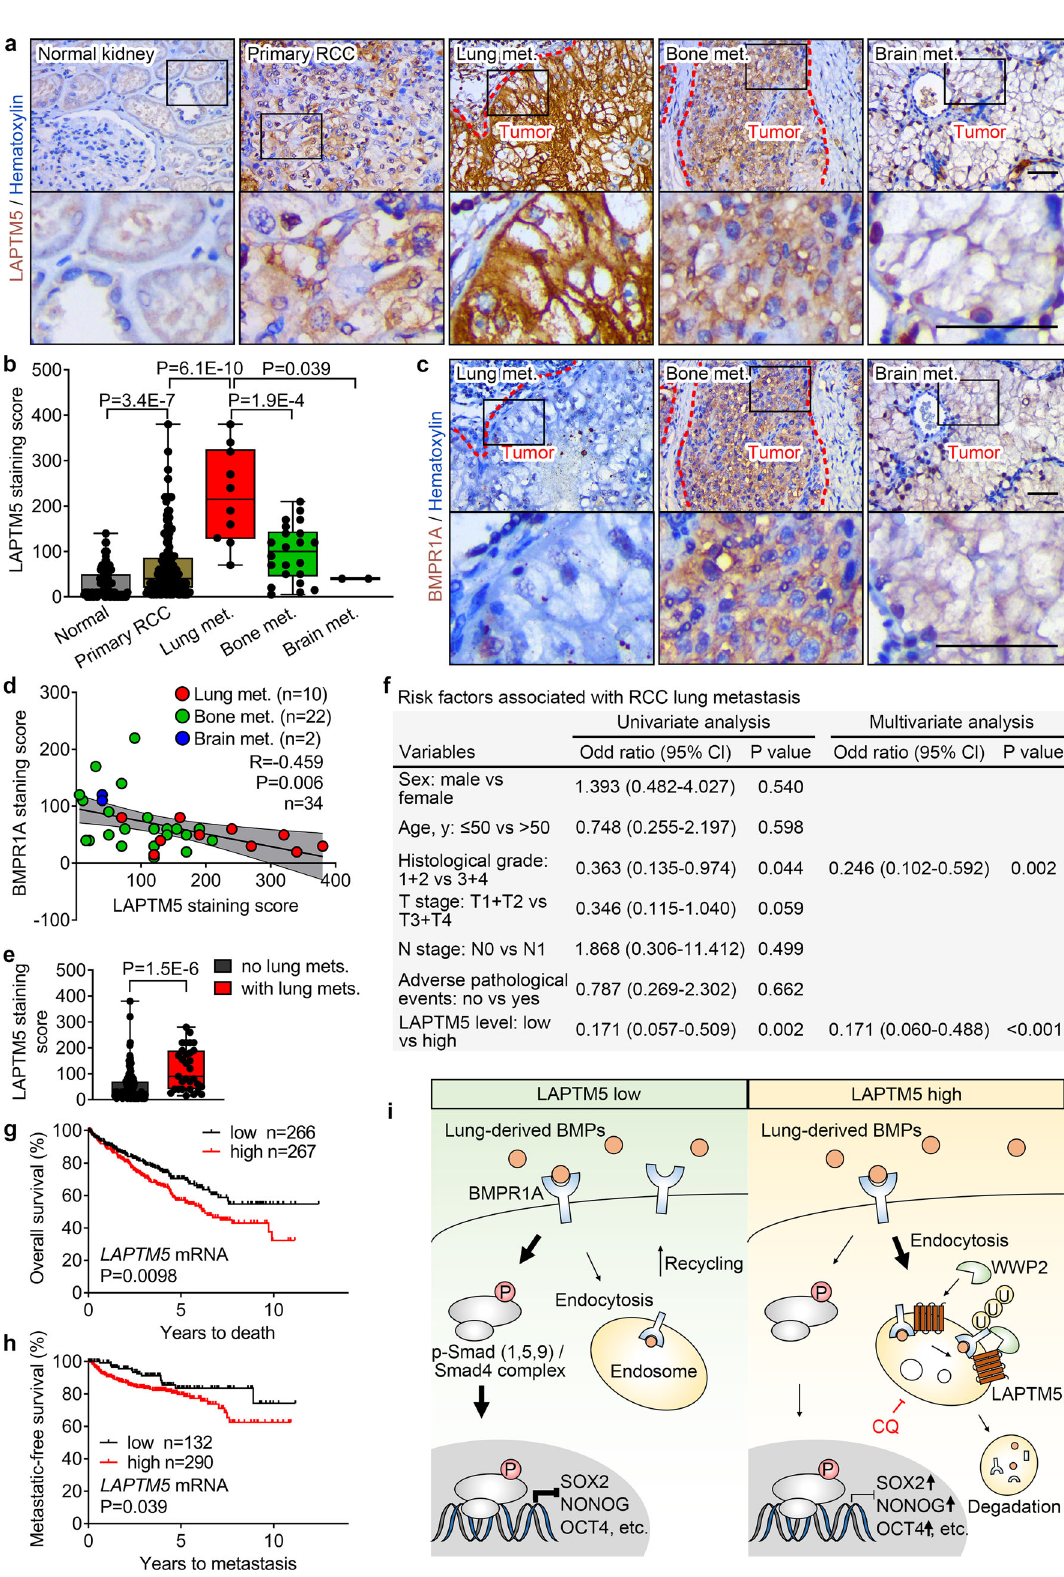
LAPTM5 may be involved in regulating the immune micro- environment in KIRC 49 . Whether LAPTM5 could also mediate lung-speci fi c metastasis by regulating in fi ltrated immune cell function in primary or metastatic foci warrants further